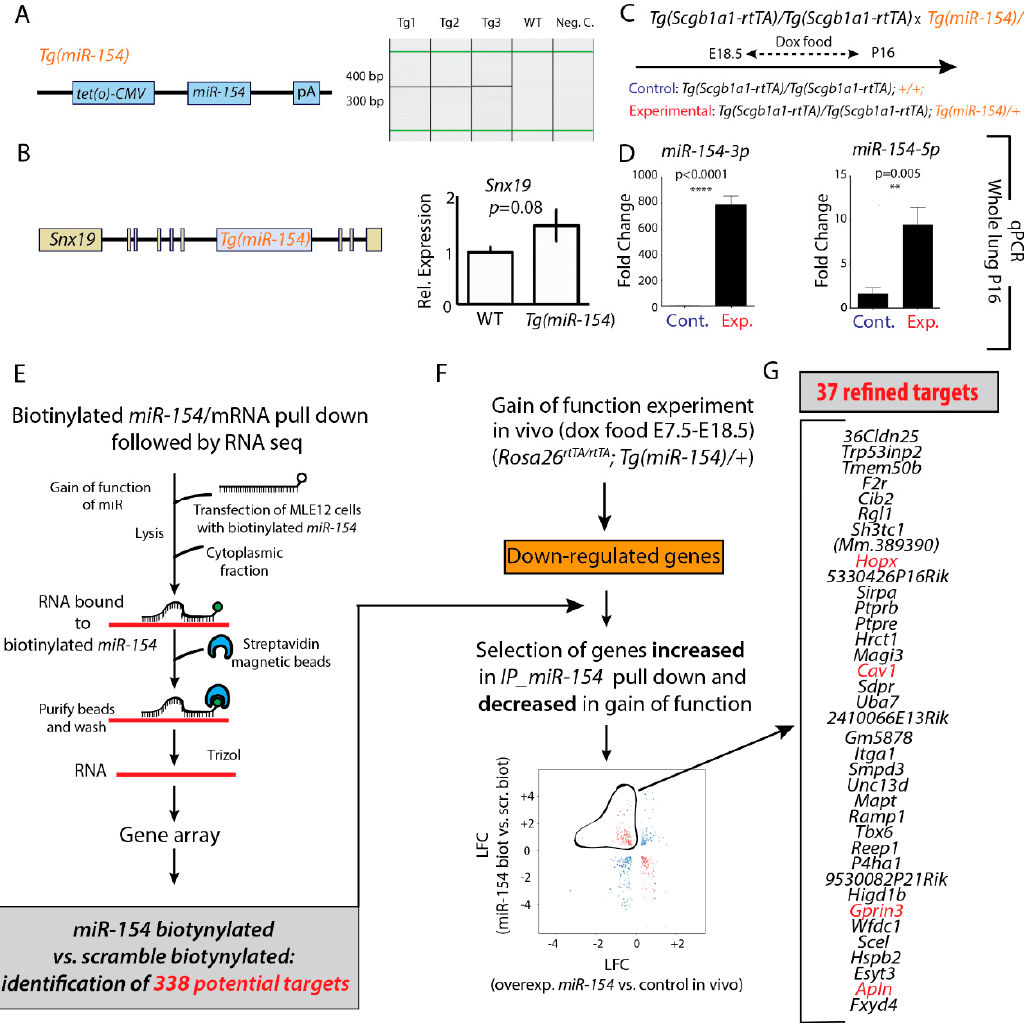
Figure 2. Generation/validation of transgenic mice for miR-154 overexpression and pull-down assay. A . Scheme of miR-154 transgene and genotyping results from Tg(tet(O)miR-154) mice. B . Scheme of Snx19 gene and the Tg integration site. Expression of Snx19 after Tg integration was analyzed by qPCR in embryonic lungs. C + D . Increased expression of miR-154-3p and miR-154-5p in double transgenic mice [ Tg((Scgb1a1-rtTA)/+ ; Tg(miR-154)/+ ] versus WT [ Tg((Scgb1a1-rtTA)/+ ; +/+] after Dox induction from E18 to P16. E – G . Pull down biotinylated miR-154 versus gain of function with mimic in MLE12 cells . [Rosa26 rtTa/rtTA ; Tg(miR-154)/+] experimental and [Rosa26 rtTa/rtTA ; +/+] control embryos exposed to Dox in utero from E7.5 to E18.5 were generated and the lungs collected for genearray analysis to identify the genes downregulated upon miR-154 overexpression. * p ≤ 0.05, ** p ≤ 0.01, *** p ≤ 0.001, **** p ≤ 0.0001.